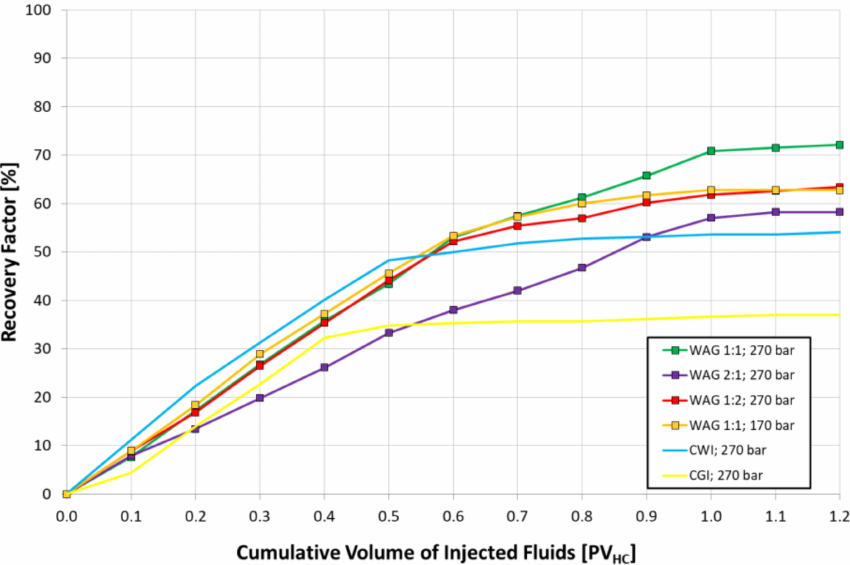
Figure 14. Oil recovery efficiency using KG with different WAG schemes compared to CWI and CGI